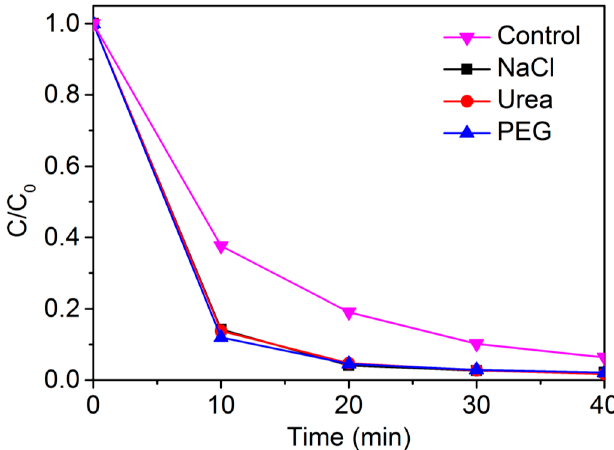
Figure 4. Concentration changes of AR1 in the presence of 0.10 mol/L NaCl, 0.10 mol/L Urea or 0.10 mol/L PEG at 25 °C with 4 × 10 − 3 mol/L H 2 O 2 ([Co III (opba)] − -Py-MWCNTs = 0.2 g/L, pH 9.0 (0.01 mol/L borate buffer)).